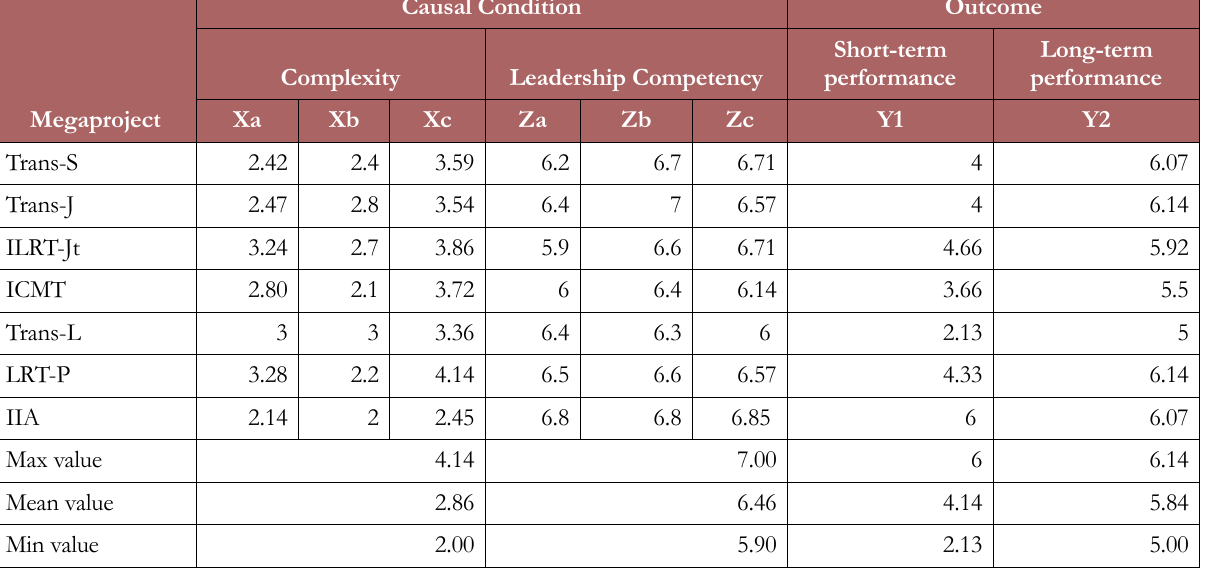
Table 2. The Original Data